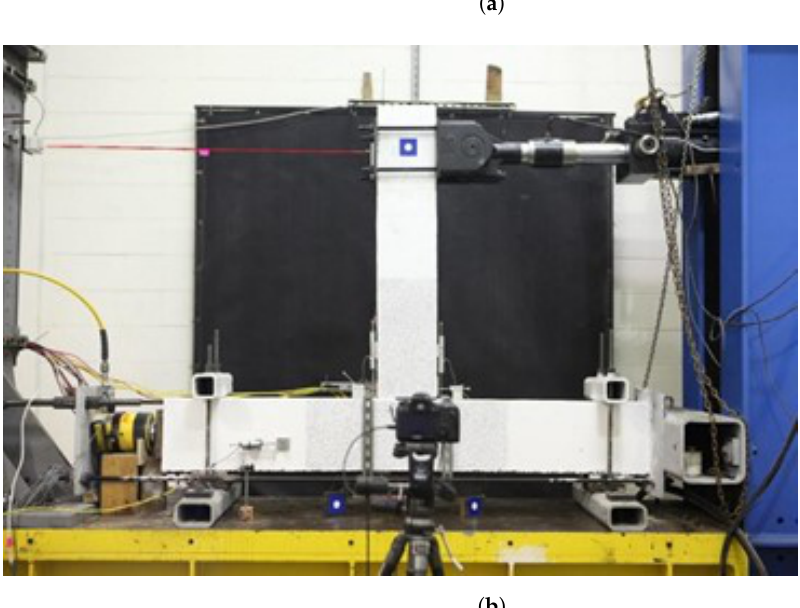
Figure 2. Test set-up used for the tests at PEER, UC Berkeley. ( a ) Illustrative sketch; ( b ) Photo: front side.